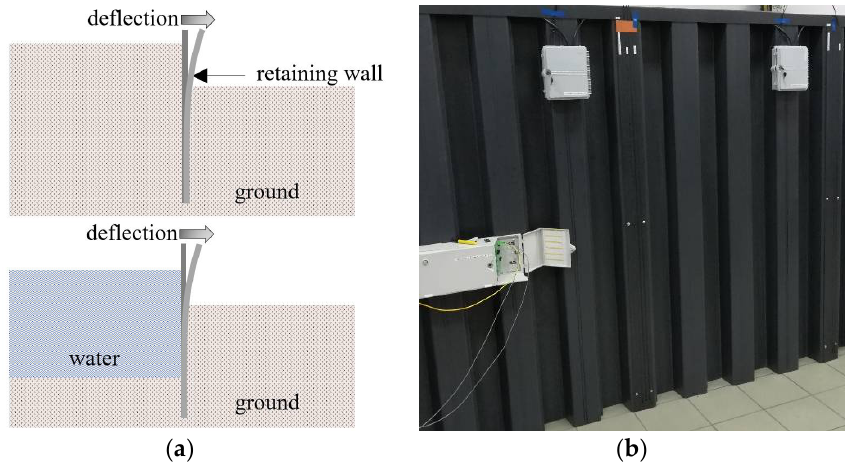
Figure 1. Retaining wall: Application diagram ( a ), photo of the demonstrator constructed in Optical Fiber Technique Laboratory ( b ).